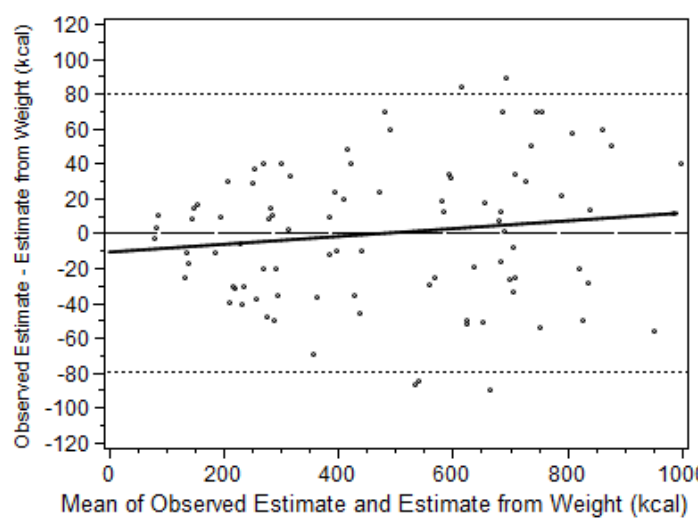
Figure 1. Agreement between the two methods of estimating energy consumption (RE and food weighing, n = 90) as depicted using the method of Bland and Altman [32]. Linear correlation between the differences and the means indicated by solid line (y = 0.02x − 10.6, r 2 = 0.02, p = 0.20). Limits of Agreement (i.e., the mean difference in estimates ± 2SD) indicated by dotted lines.